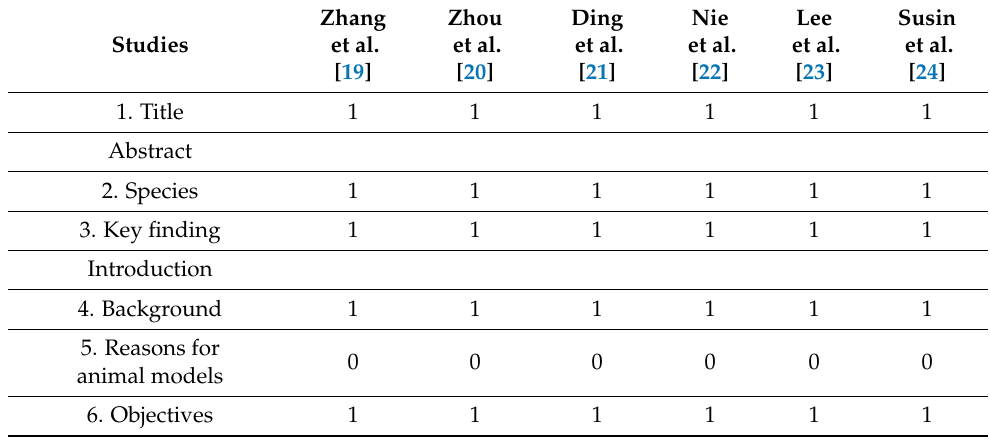
Figure 4. SYRCLE’s (Systematic Review Centre for Laboratory Animal Experimentation) risk of bias tool. Table 4. Checklist of ARRIVE criteria reported by the included studies .